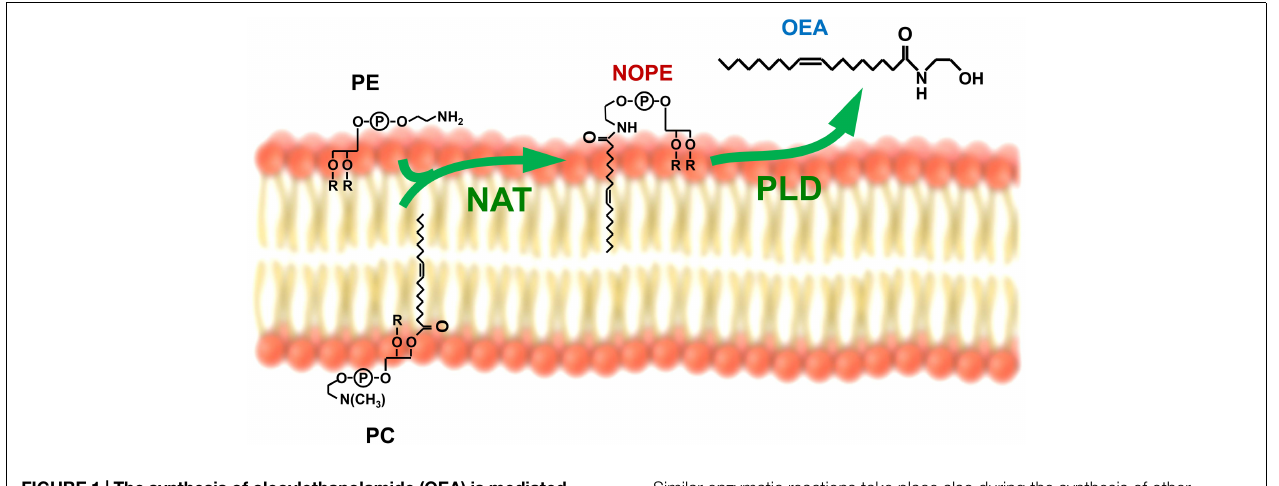
FIGURE 1 | The synthesis of oleoylethanolamide (OEA) is mediated by two concerted reactions: The first one is the N -acylation of phosphatidylethanolamine (PE) from the phospholipid bilayer of the cell membrane, mediated by a N-acyltransferase (NAT) to form N -oleoylphosphatidylethanolamine (NOPE) and the second one is the phospholipase D (PLD)-mediated hydrolysis of NOPE.